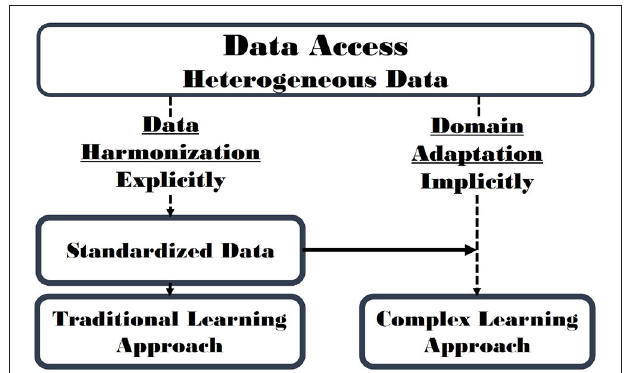
FIGURE 3 | Data Harmonization (section 3) and Domain Adaptation (section 4) are related concepts that address issues related to batch effect correction. Data Harmonization attempts to standardize images, explicitly minimizing the batch effects. Conversely, Domain Adaptation implicitly corrects batch effects while achieving the modeling objective. A hybrid approach that first includes elements of data harmonization and is followed by a domain